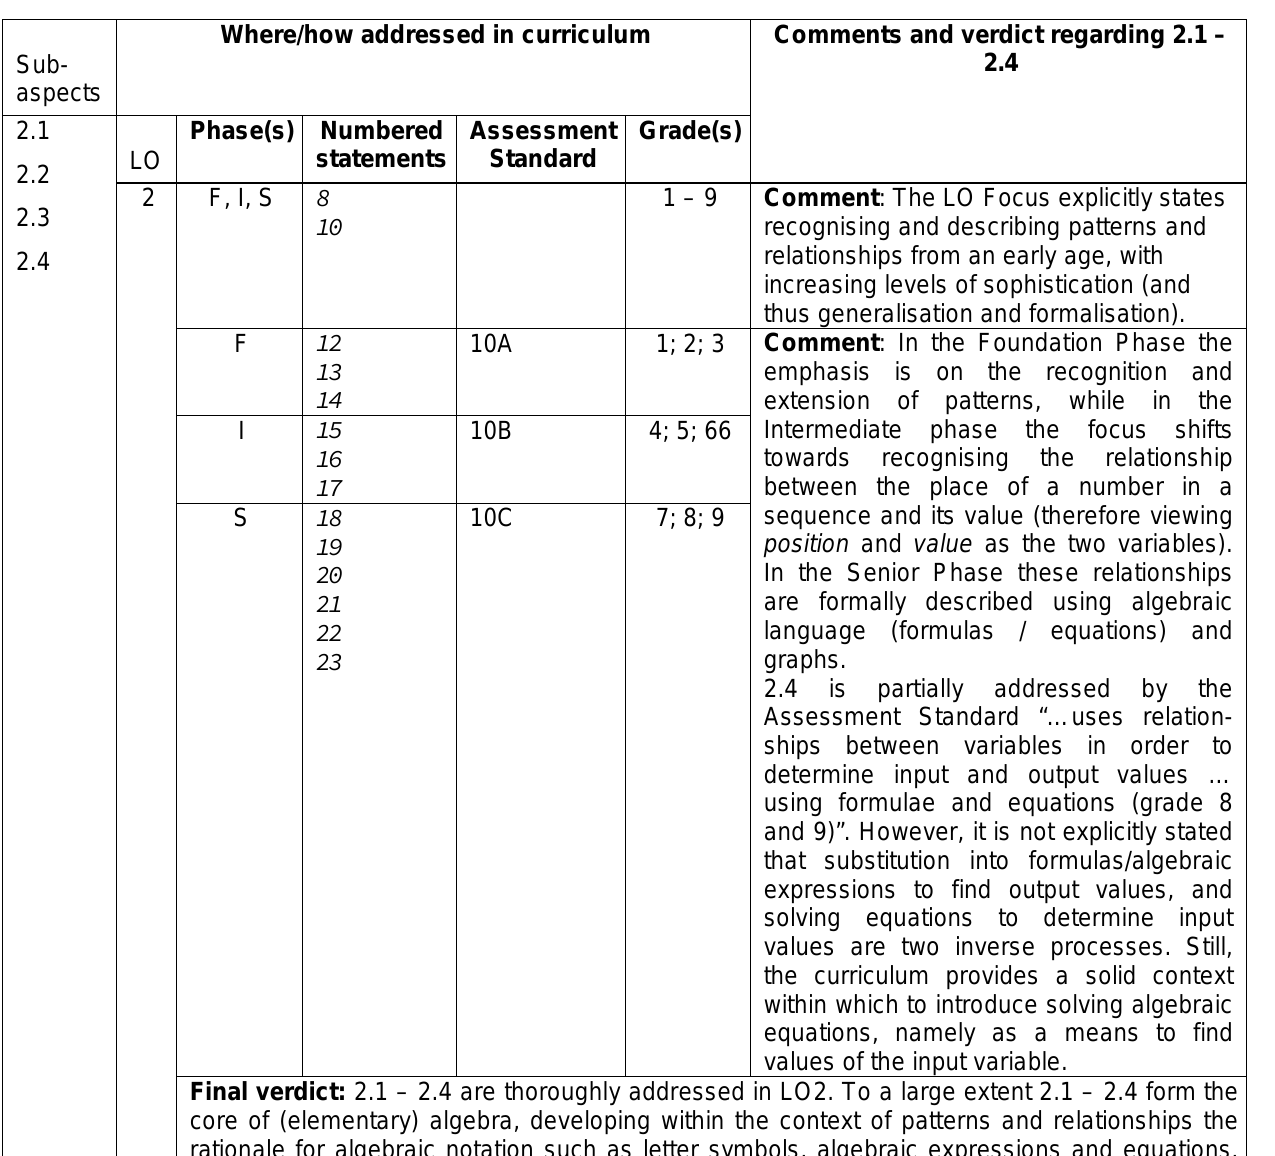
Table 10. Aspect 2: enable learners to use and appreciate algebra as a means to describe relationships between quantities